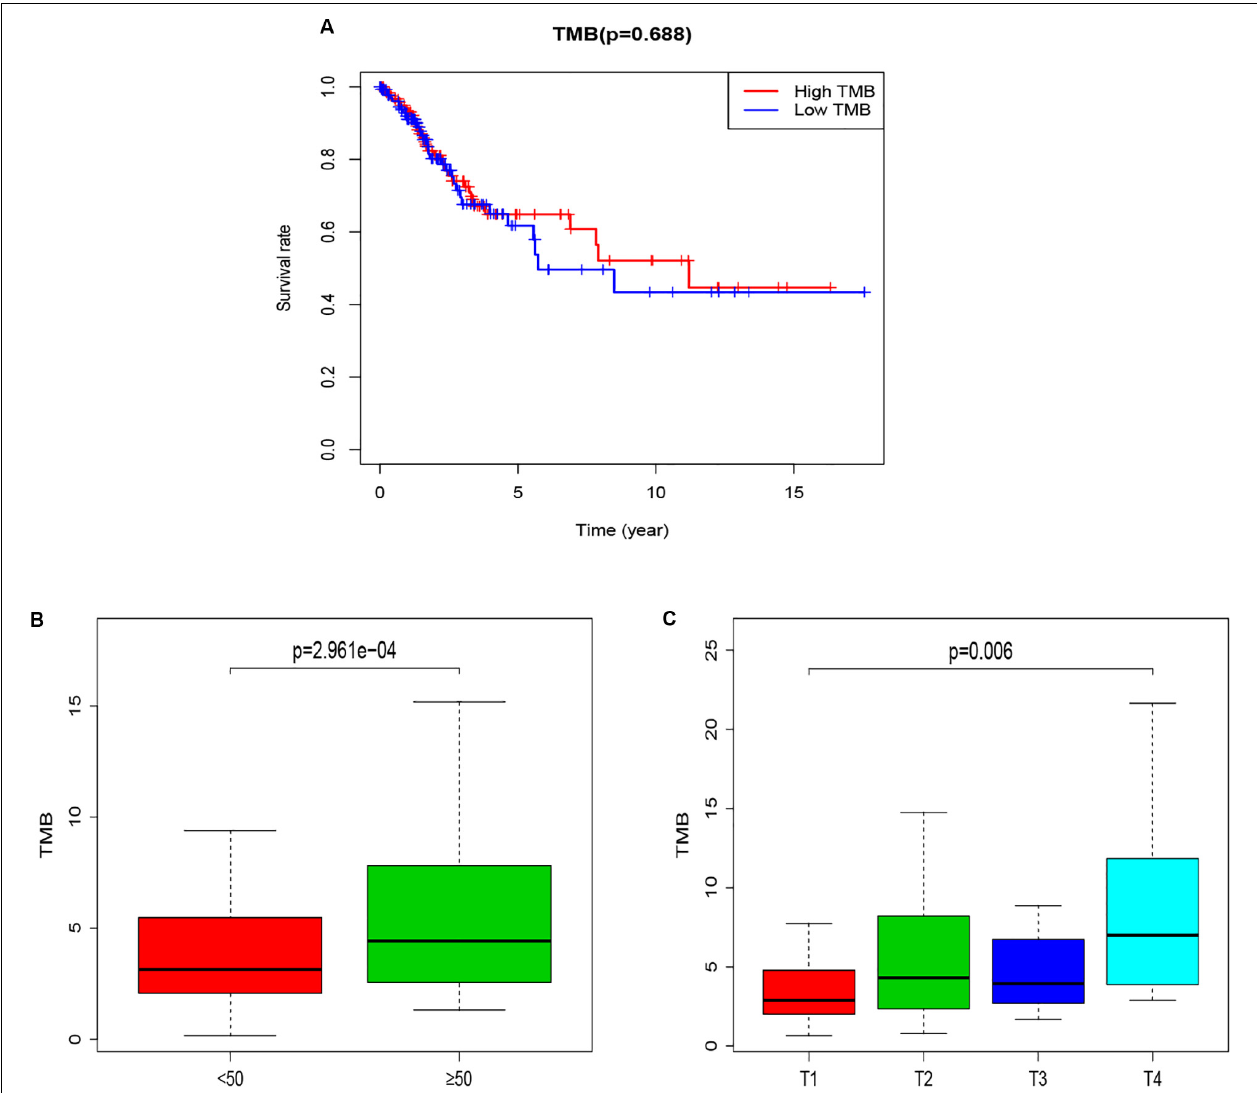
FIGURE 2 | The relationship between TMB and Survival and clinical characters of age and T staging. (A) Kaplan-Meier survival curves for high-TMB subtypes (red line) and low-TMB subtypes (blue line). (B) Correlation analysis between TMB and age (with 50 years old as the cut-off point). (C) Correlation analysis between TMB and T staging. TMB, mutant tumor